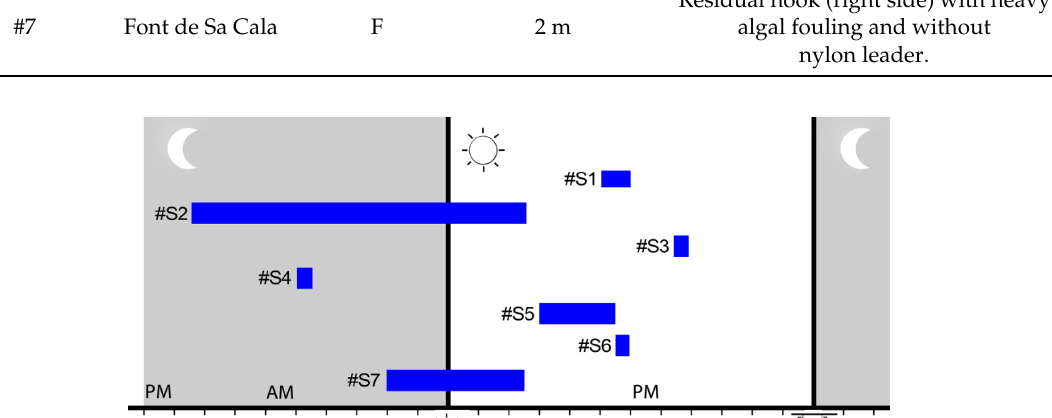
Figure 2. Occurrences of the seven blue sharks (numbered from #S1 to #S7) during the experiments showing four animals that appeared only during the day between 9 AM and 2 PM, and three animals that appeared mostly at night between 10 PM and 9 AM (appearance timing in contrasted blue colour).